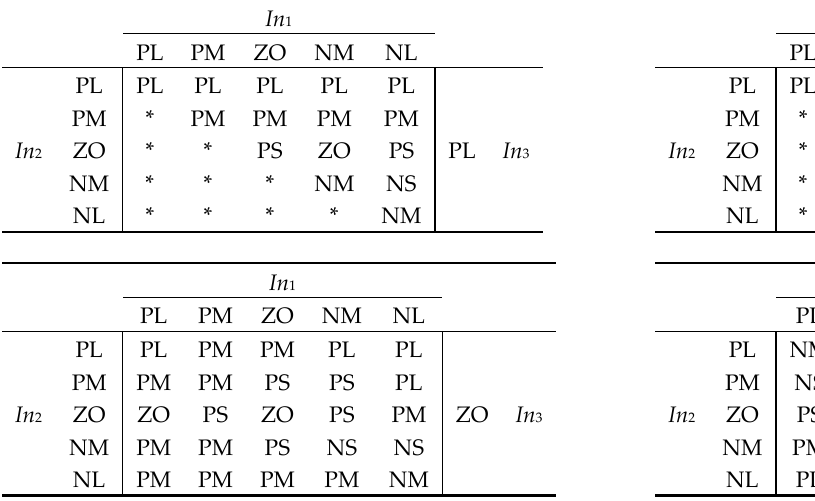
Table 2. Fuzzy control rules for the integral gain. Tables 2. Fuzzy control rules for the integral